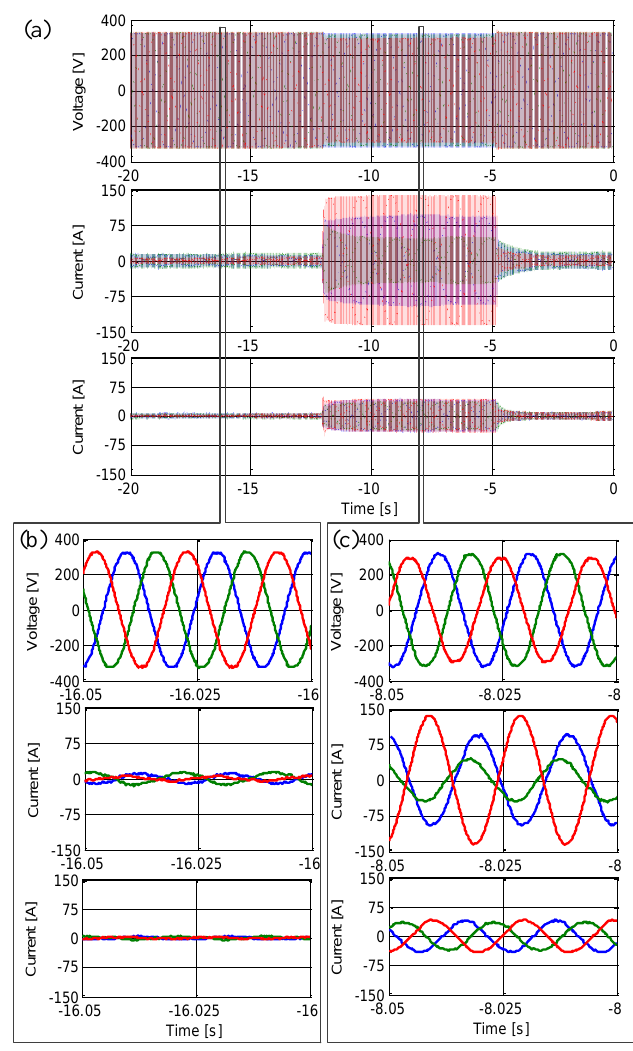
Figure 16. Two SPC-based converters working with different negative-sequence virtual admittances. The PCC voltage and current injection: ( a ) the whole experimental process; ( b ) prior to the fault; and ( c ) during the fault.